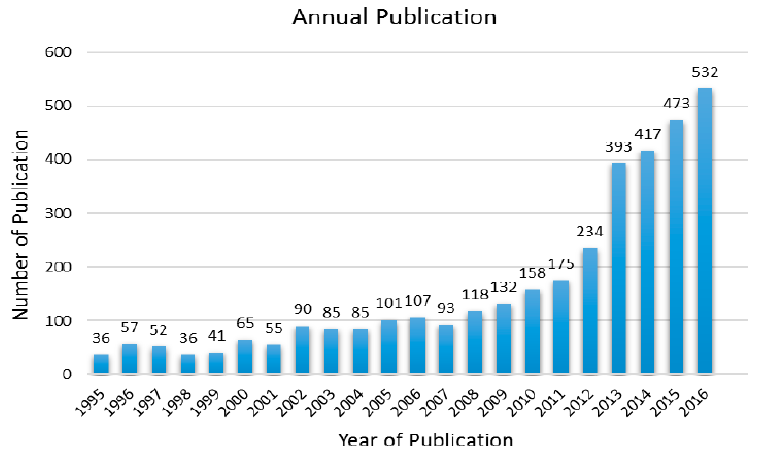
Figure 1. Annual number of scientific research publications on halloysite in the past two decades (using the SciFinder Scholar search system to obtain the above data, as of December 2016).